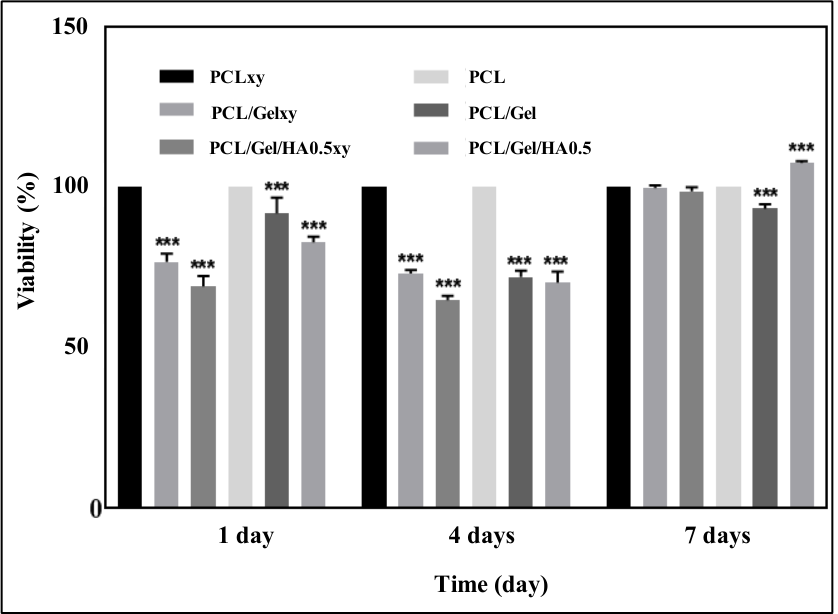
Figure 7. Cell viability of U251 cells cultured on PCL, PCLxy, PCL/Gel, PCL/Gelxy, PCL/Gel/HA, and PCL/Gel/HAxy scaffolds for 1, 4, and 7 days. Data are the means ± S.E.; n = 3; ***, p ≤ 0.001 versus control, ANOVA, Bonferroni’s multiple comparison test.